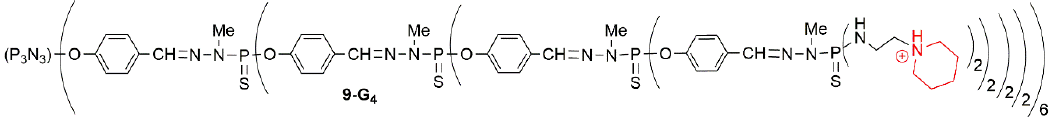
Figure 12. First generation dendrimer bearing pyrrolidinium terminal functions.